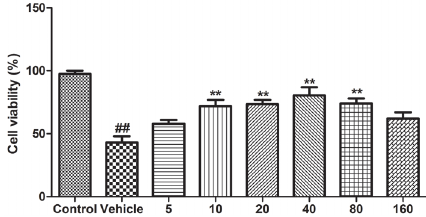
Figure 5. Effects of baicalin (BA) on the viability of PC12 cells. Data are reported as means ± SE (n=8). ## P o 0.01 vs control; **P o 0.01 vs vehicle